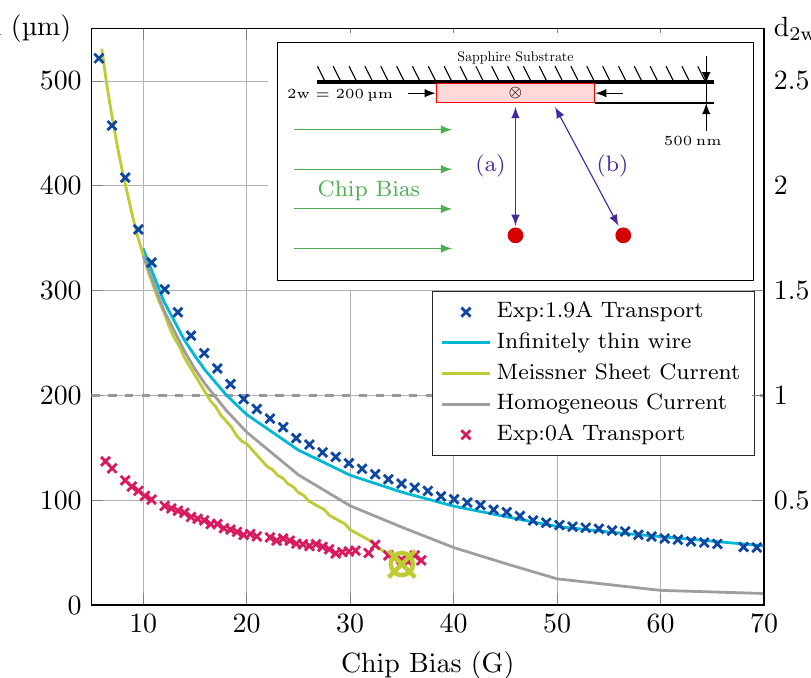
Figure 2: Distance of the atomcloud to the chip surface versus the applied bias field. The discrete crosses and circles are measurements for an applied transport current of 1.9 A and 0 A, respectively. The target trapping current is always ramped from zero. The solid curves shown are the position of the field minimum from the full 3D simulation of the wire geometry according to various cross-sectional current distribu- tions. The yellow-green curve assumes a Meissner-London current distribution [ 41 ] . The gray curve is for a homogeneous current across the 200 µ m width. The light- blue curve is for a single thin wire. The dashed line illustrates the boundary where = 1 ( d = 2 w ). The inset shows a basic diagram of the trapping wire with an ap- d 2 w plied current plus an external bias field. (a) and (b) shows the direction of the trap relative to the wire for a purely current-induced and field-induced magnetization, respectively. See section 4.2 of the text. The measured d always gives the distance of the atoms to the atomchip surface irregardless of its relative position [ 39 ]